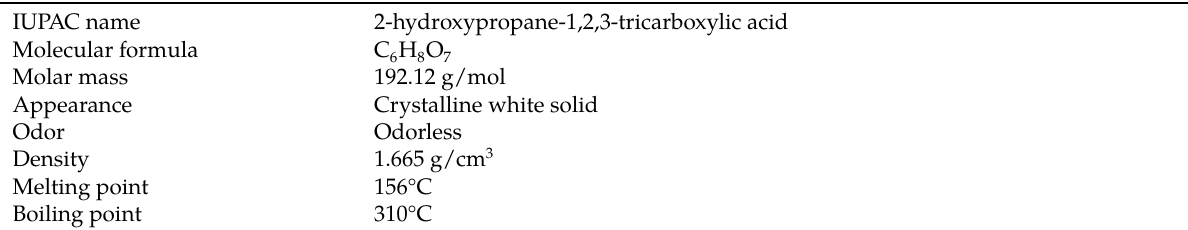
Table 4: Properties of citric acid [bib, https://en.wikipedia.org/wiki/Citric_acid].